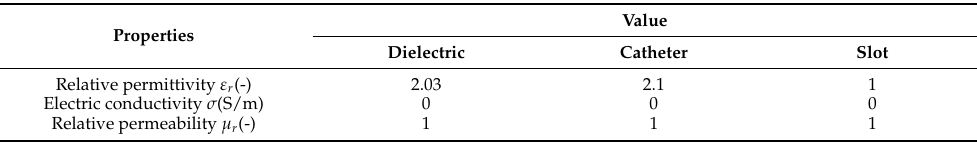
Table 2. The dielectric properties of a single-slot MW antenna [24].